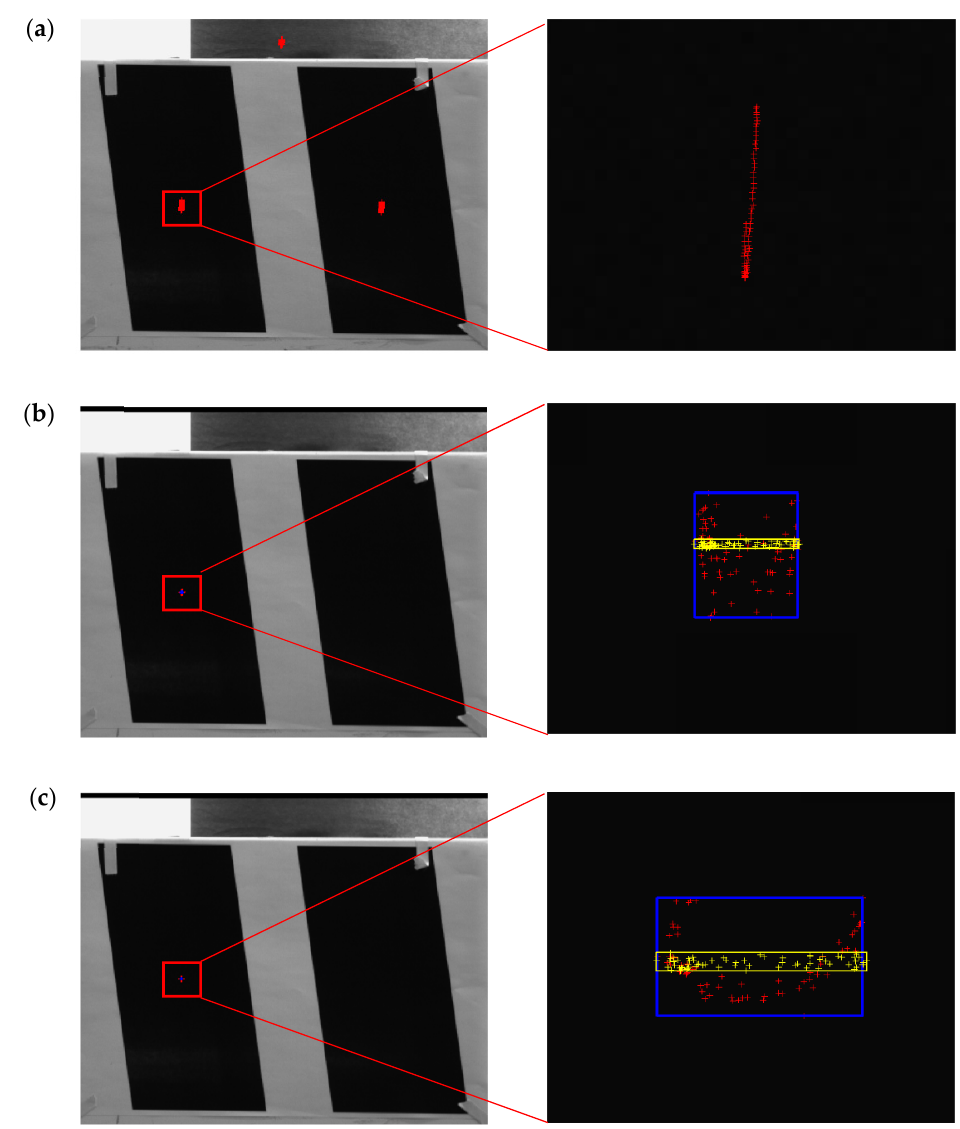
Figure 16. Distribution of centroids after image pixel offset compensation for different algorithms: ( a ) distribution of the centroid when the vertical axis has attitude changes; ( b ) distribution of the image pixel offset compensation centroid after using the attitude estimated by the traditional in- terpolation algorithm; ( c ) distribution of the image pixel offset compensation centroid after using the attitude estimated by the KLFF algorithm. The red dots are the image centroids of different frames, the blue matrix is the image pixel offset compensation centroid after using the KLFF algorithm, and the yellow matrix is the image pixel offset compensation centroid after centroid extraction for com- parison.